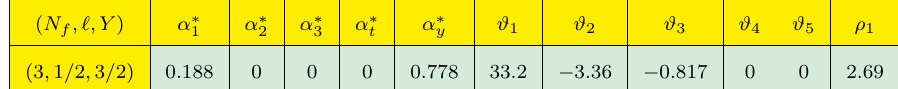
Table 8 . Values of the couplings at the (cid:12)xed point, eigenvalues and (cid:26) almost works ( 210 approximation scheme).